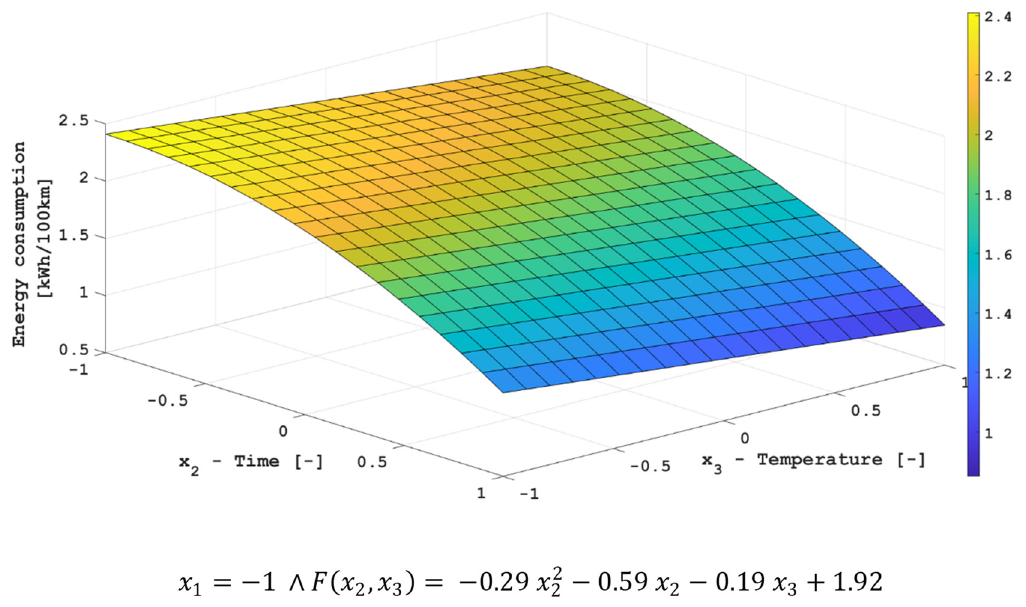
Figure 2. The energy demand of the scooter when covering the 5 km route.